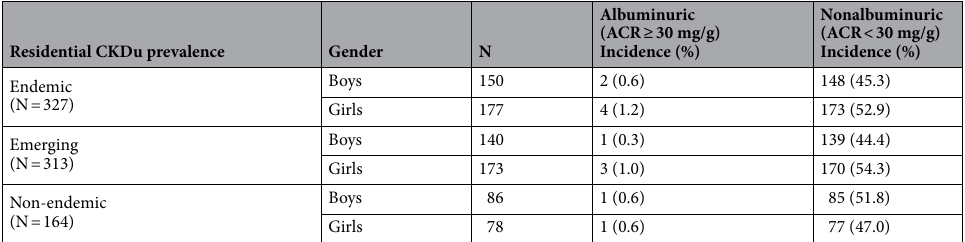
Table 5. ACR-based stratification of the potential risk of renal injury and the related incidence in children from CKDu endemic, emerging, and non-endemic regions. The incidence is given as the number and percent of the total size of the study group in the respective region; CKDu endemic, emerging or non-endemic. ACR albumin creatinine ratio.